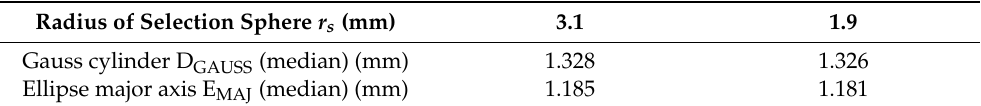
Table 3. Influence of the selection sphere size (lattice structure #6).